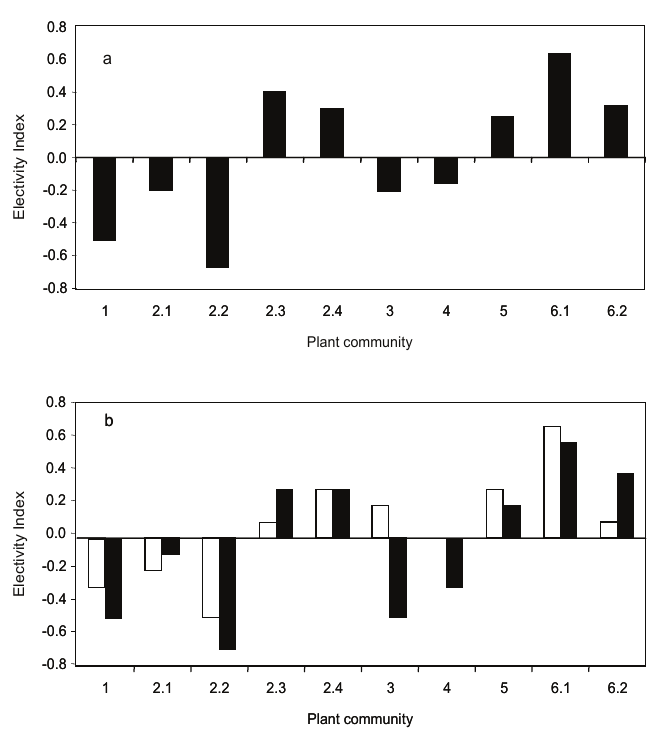
Fig. 5. The overall utilisation of plant communities in relation to their avail- ability (a), expressed as an electivity index, together with seasonal prefer- ences (b) for both the dry (open bars) and wet seasons (black bars). Plant community numbers are the same as those used in Fig.